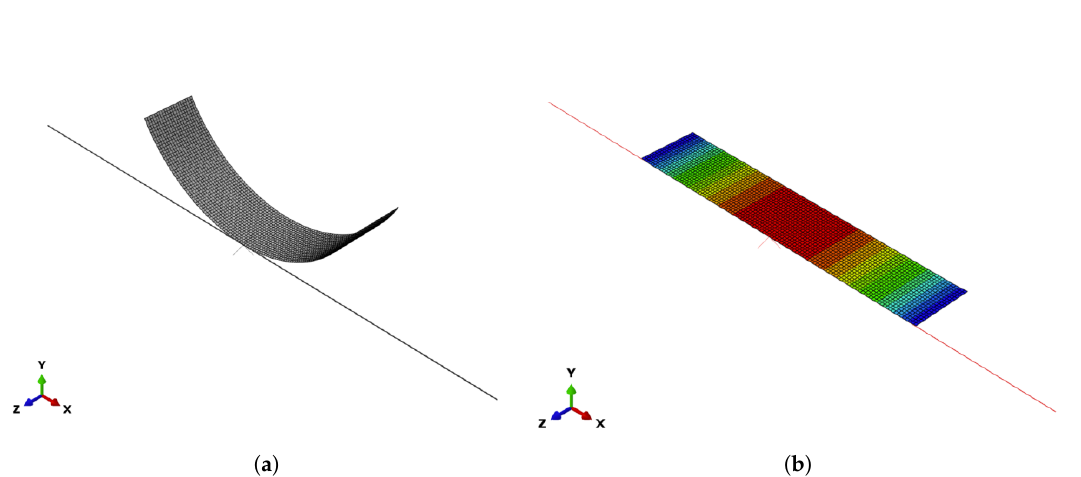
Figure 8. FEA model to determine the stress-free temperature for a given curvature of an asym- metric specimen. ( a ) Curved specimen in its initial state; ( b ) Flat specimen after applied tempera- ture